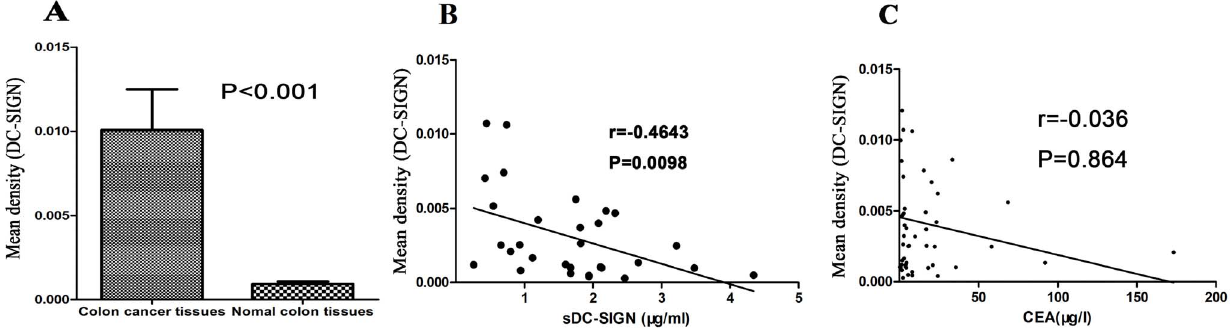
Fig. 5. Semi-quantitative image analysis of DC-SIGN expression in tissues and the analysis of its correlation with sDC-SIGN and CEA in serum from the same patient. A : There was statistical significance in IHC for DC-SIGN expression between colon cancer tissues and matched normal colon tissues, P , 0.001. DC-SIGN expression in colon cancer patients was higher than in normal colon tissues; B : The correlation between DC-SIGN staining intensity in colon cancer tissue and sDC-SIGN level in serum from the same patient. The mean density (Yaxis) was negatively correlated with sDC-SIGN (X axis), r 52 0.4643, P , 0.01; C : The correlation between the mean density of DC-SIGN in colon cancer and CEA in serum. No significant correlation was observed between the mean density (Y axis) and CEA (X axis), with a Spearman correlation coefficient of -0.036, P .